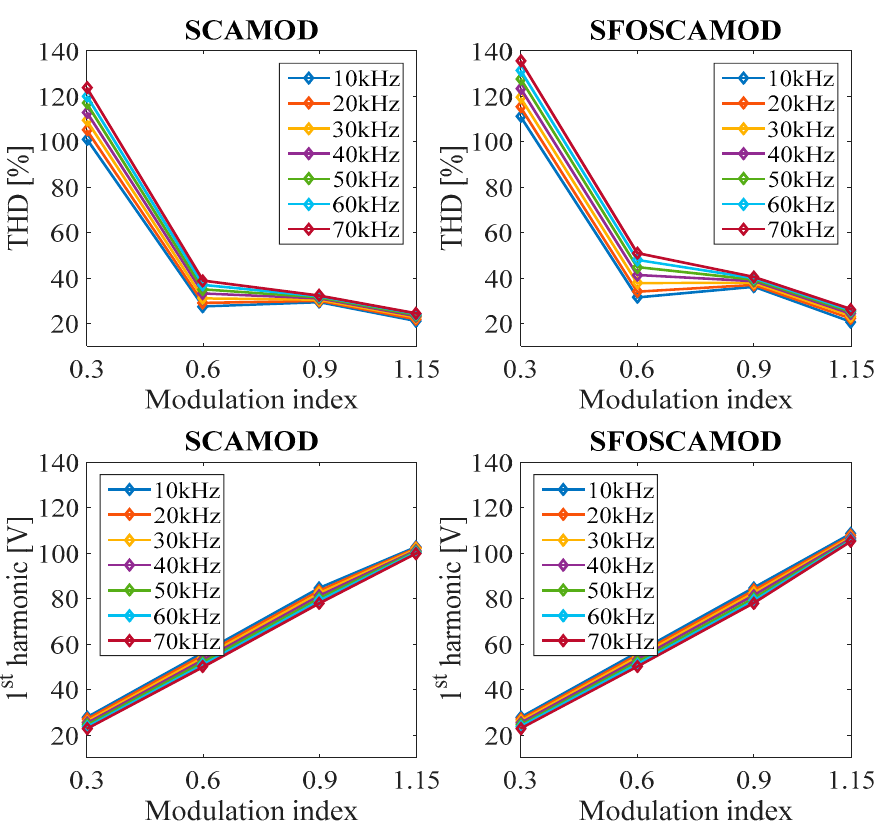
Figure 18. Experimental THD% and fundamental amplitude trends of SCAMOD and SFOS ‐ CAMOD schemes.